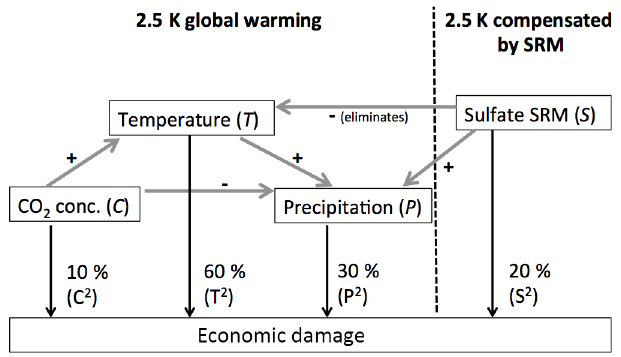
Figure 1. Graphical representation of the damage function. The thin black arrows represent contributions to the damage function, while grey arrows depict how the climate variables influence each other ( + and − stand for increasing and decreasing effects, respec- tively, see Eqs. 4b and 6). The percentages for C , T , and P are based on the contributions of these variables for the standard case of 2.5K warming in equilibrium and in absence of SRM. In this standard case, our damage equals that of the DSICE model (Cai et al., 2012). The sulfur injections that would be needed to offset 2.5K warming cause a direct damage of 20% of the standard damage